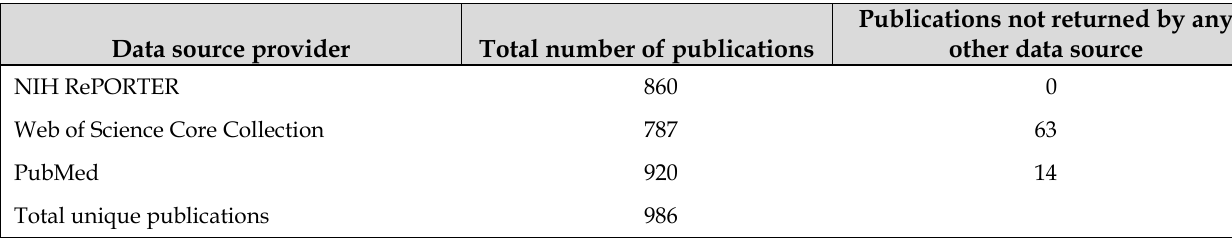
Table 1 Publication results by data